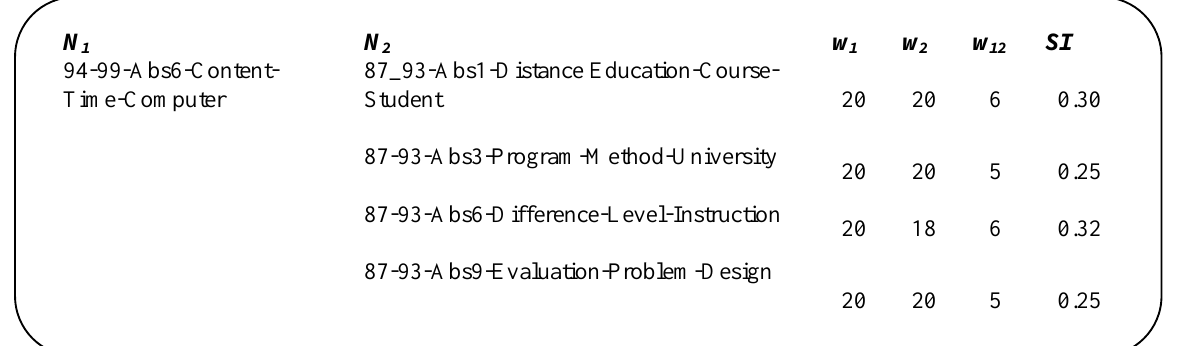
Figure 10 . Similarity index for